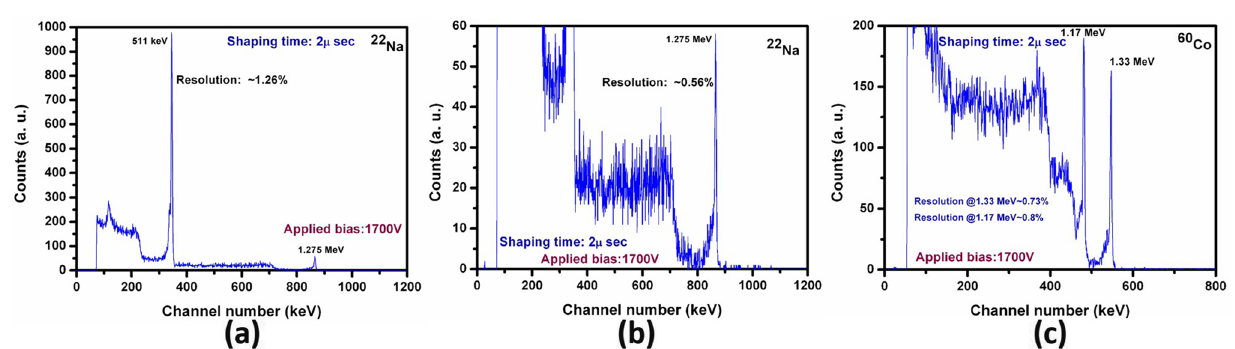
Figure 7. Pulse height spectrum of ( a ) 22 Na source of the Frisch-grid detector fabricated from as-grown Cd 0.9 Zn 0.1 Te 0.98 Se 0.02 THM-grown ingot, ( b ) magnified version of ( a ), and ( c ) 60 Co energy spectrum. Detector dimensions: 3.5 × 3.5 × 9.15 mm 3